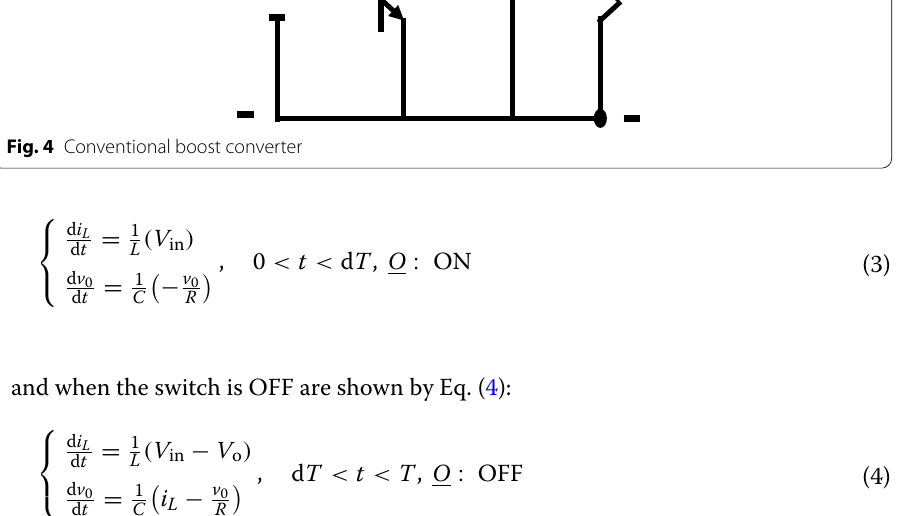
Fig. 4 Conventional boost